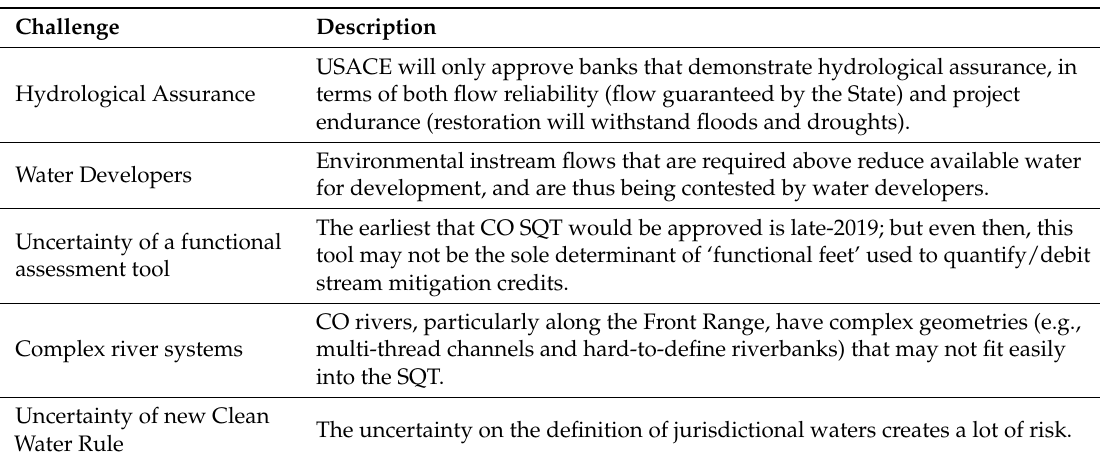
Table 10. Major challenges for stream mitigation banks in Colorado